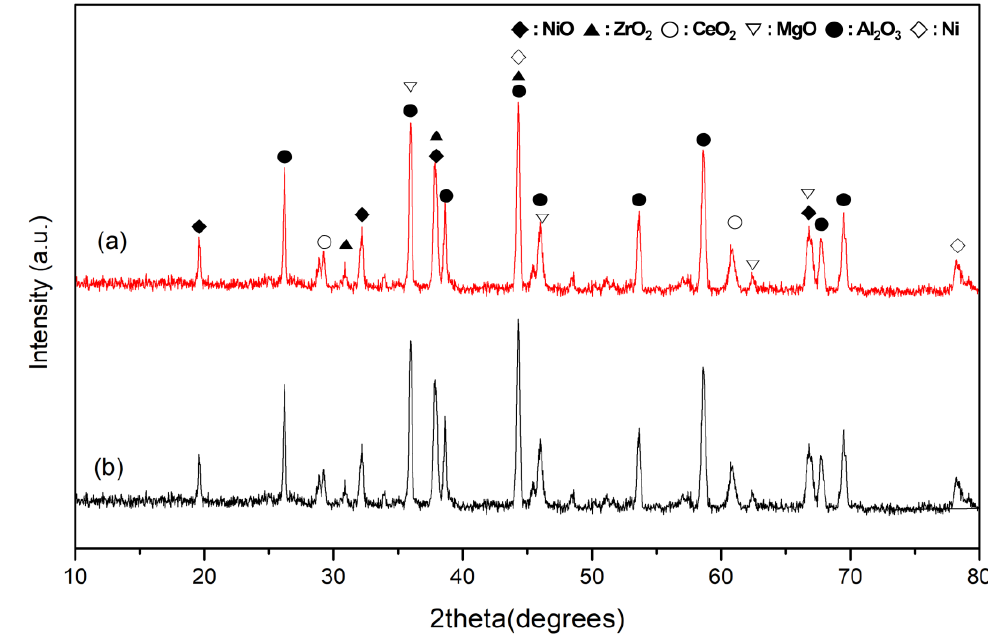
Figure 4. X-ray diffraction patterns of ( a ) Fresh and ( b ) Spent 3 wt.% Ni/Ce-Mg-Zr/Al 2 O 3 catalyst.